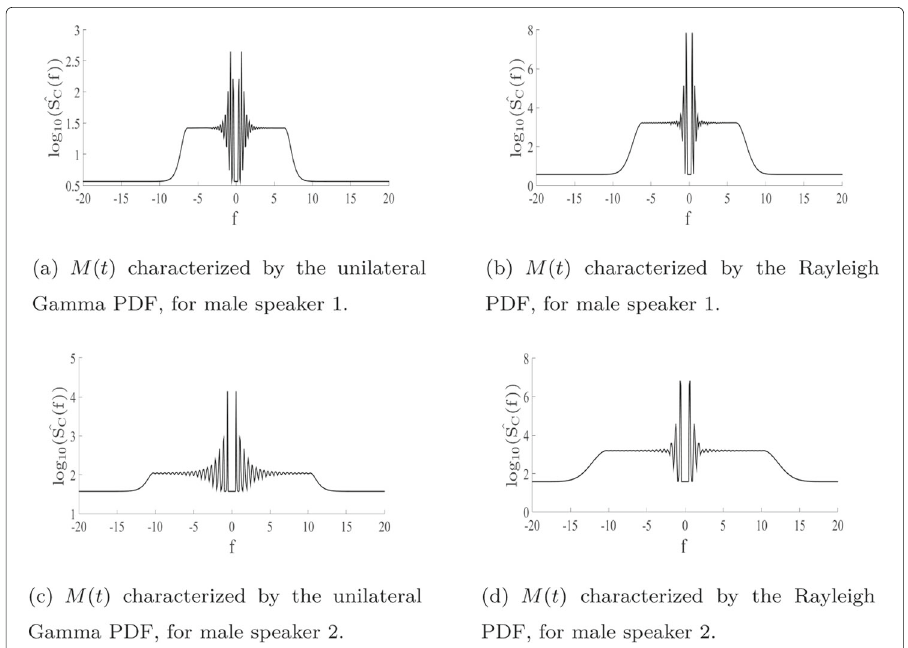
Fig. 6 PSD estimates, log 10 ( ˆ S C ( f )) ( db ) , as a function of f ( × π rad/s ) , of an impulse train modulated in position by a random signal M ( t ) characterized by two PDFs for male